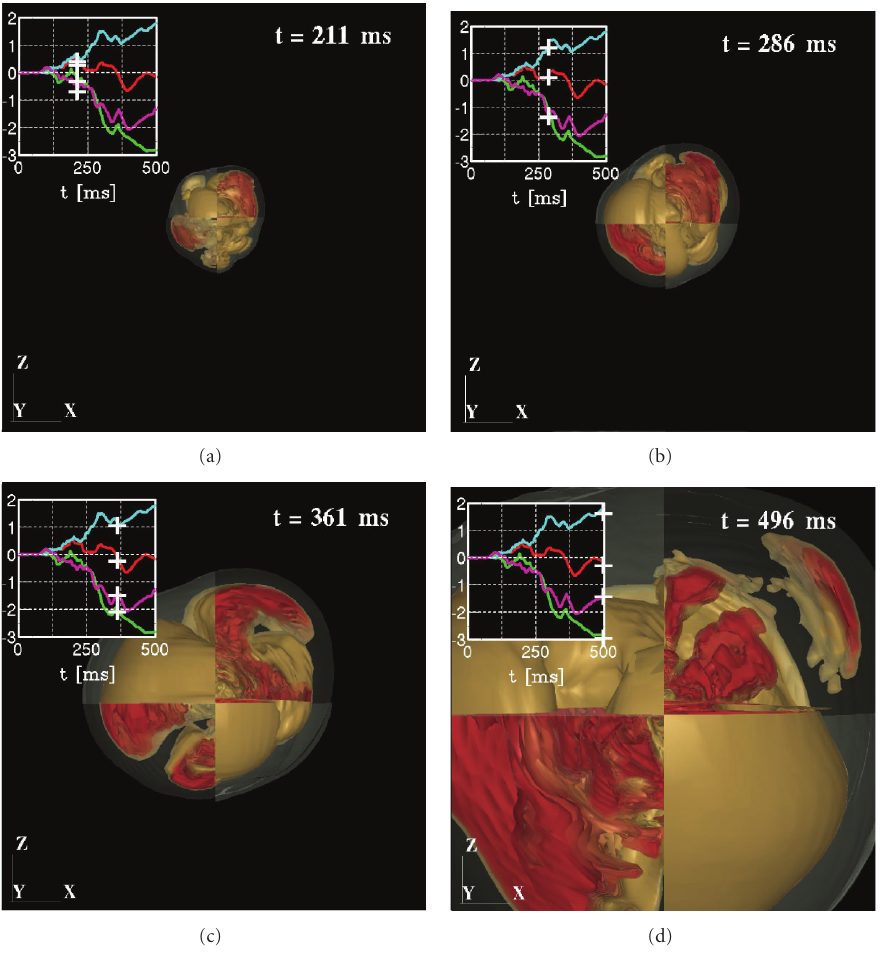
Figure 9: Four snapshots of the entropy distributions of a representative 3D supernova explosion model (corresponding to model A in [194]). The second and fourth quadrants of each panel show the surface of the standing shock wave. In the first and third quadrants, the profiles of the high entropy bubbles (colored by red) inside the section cut by the ZX plane are shown. The side length of each plot is 1000 km. The insets show the gravitational waveforms from anisotropic neutrino emissions, with “+” on each curve representing the time of the snapshot. Note that the colors of the curves are taken to be the same as the top panel of Figure 10. This figure is taken from